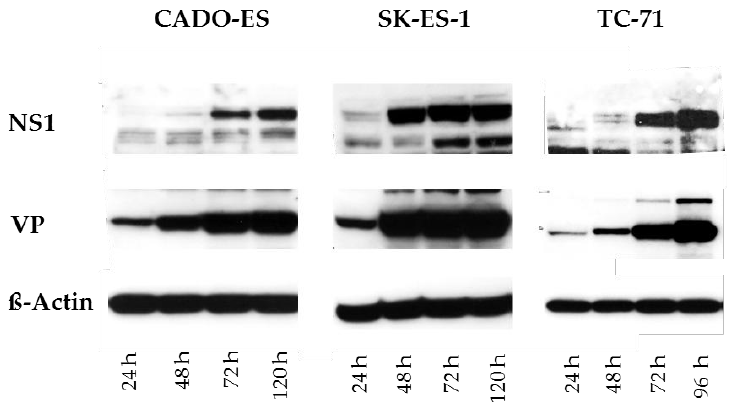
Figure 1. Protoparvovirus H-1 (H-1PV) can infect human Ewing sarcoma cells. At the time points indicated after mock infection or infection with H-1PV at MOI = 1 PFU/cell, cells were collected for protein extraction and western blot analysis. Viral proteins were detected with polyclonal antisera against the viral nonstructural protein 1 (NS1, 100 kD) and the capsid proteins 1 and 2 (VP1, 97 kD, and VP2, 68 kD). Detection of beta-actin (45 kD) was used as the loading